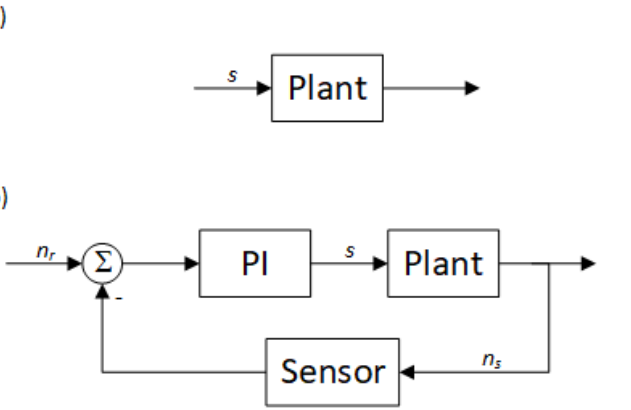
Figure 2. Diagrams of investigated control systems: ( a ) open-loop system; ( b ) closed-loop system.